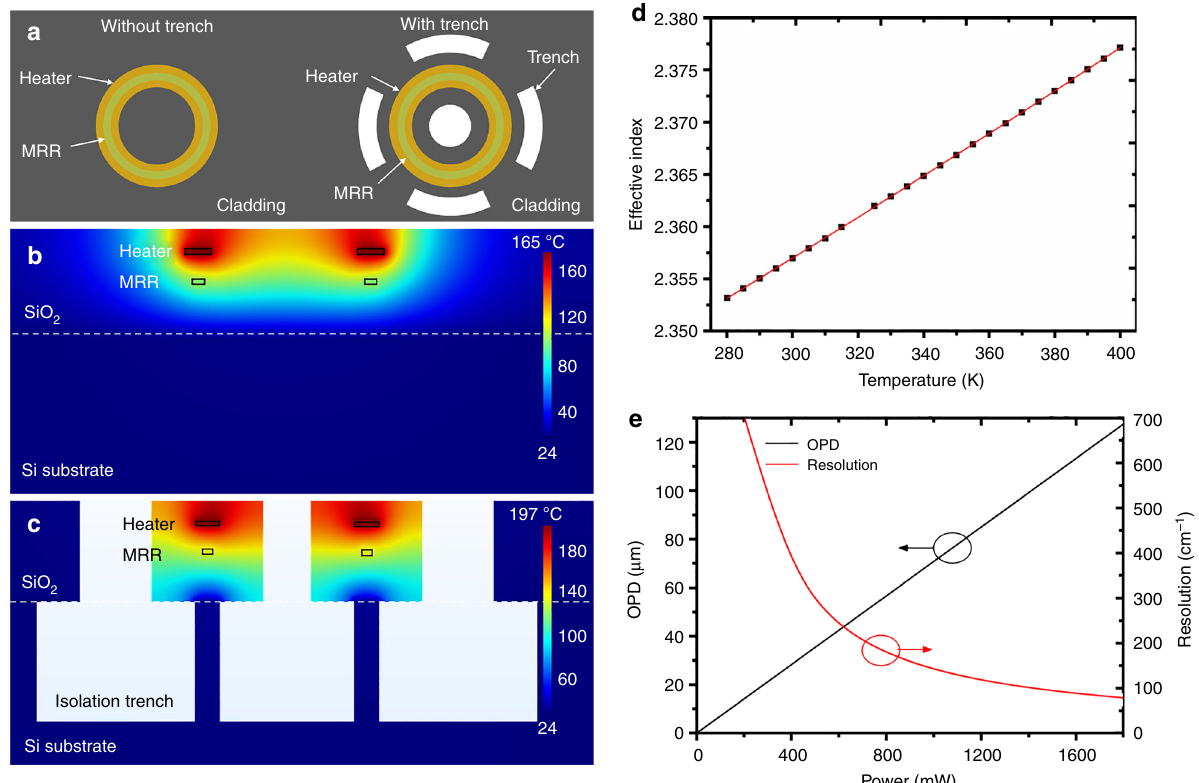
Fig. 2 Silicon-on-insulator (SOI) waveguide thermal tuning. a Schematic top views of a tunable MRR without and with isolation trenches. Simulated static temperature distribution in the cross-section of a tunable MRR with constant heating power P on the heater above b without isolation trenches and c with isolation trenches. d Relation between effective index of the quasi-TE mode and temperature. e Relation between OPD, resolution of the tunable MZI, and heating power on MZI heater